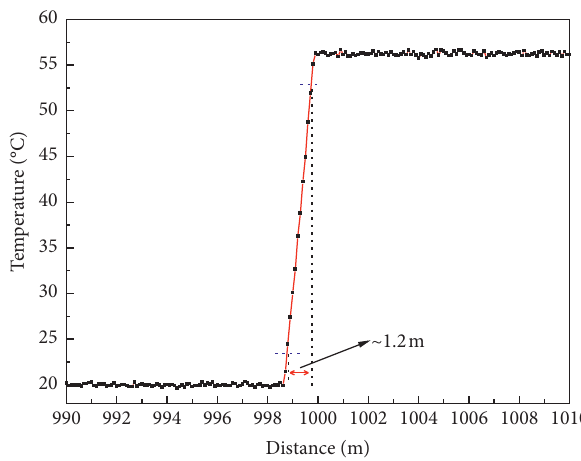
Figure 9: Spatial resolution measurement of the Brillouin sensing